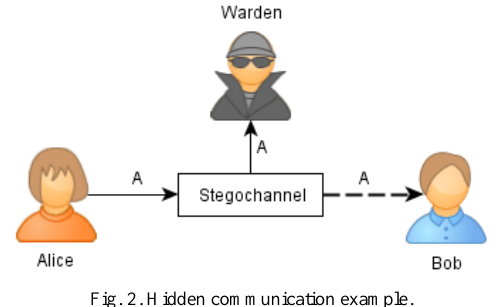
Fig. 2. Hidden communication